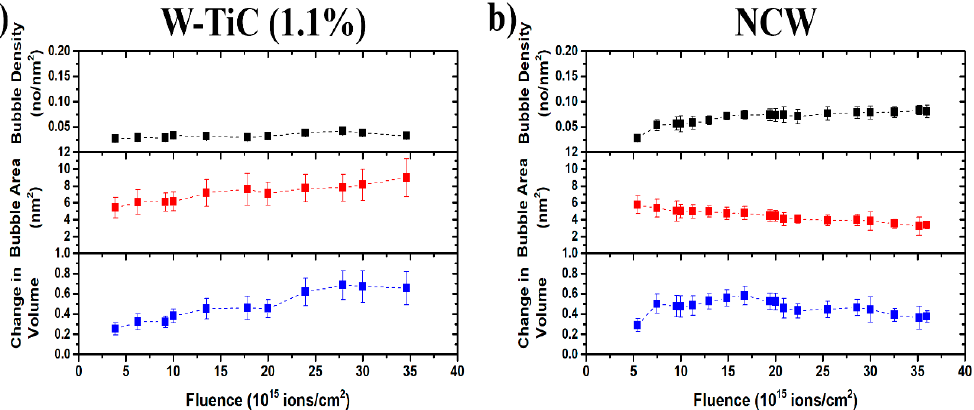
Figure 4. (Color online) Helium bubble density, average area, and the total change in volume in the grain matrices of ( a ) W-TiC and ( b ) NCW as a function of He + implantation fluence. (For interpretation of the references to color in this figure legend, the reader is referred to the web version of this article.)